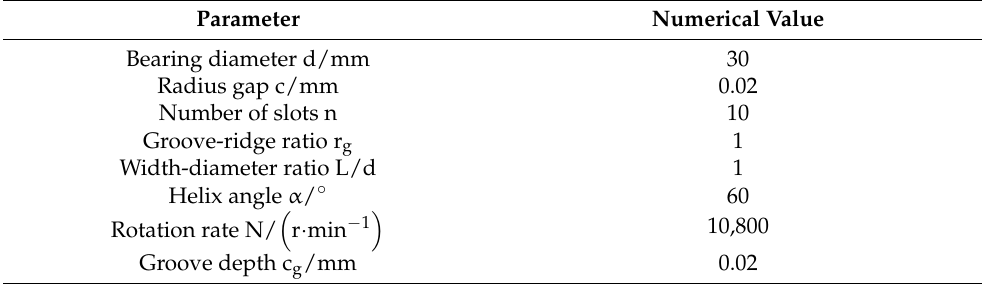
Table 2. The parameters of the lubricant.